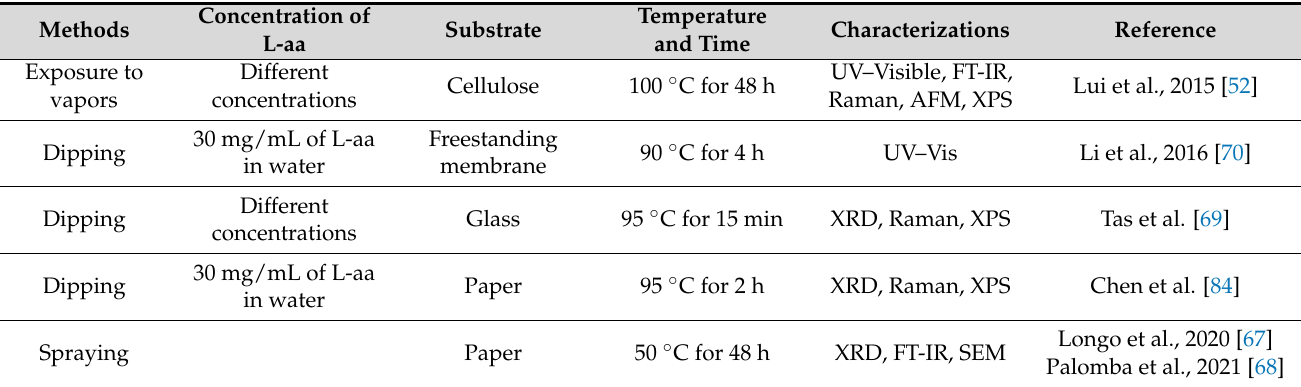
Table 2. Summary of principal parameters used in the cited methods of the gel-phase reduction of